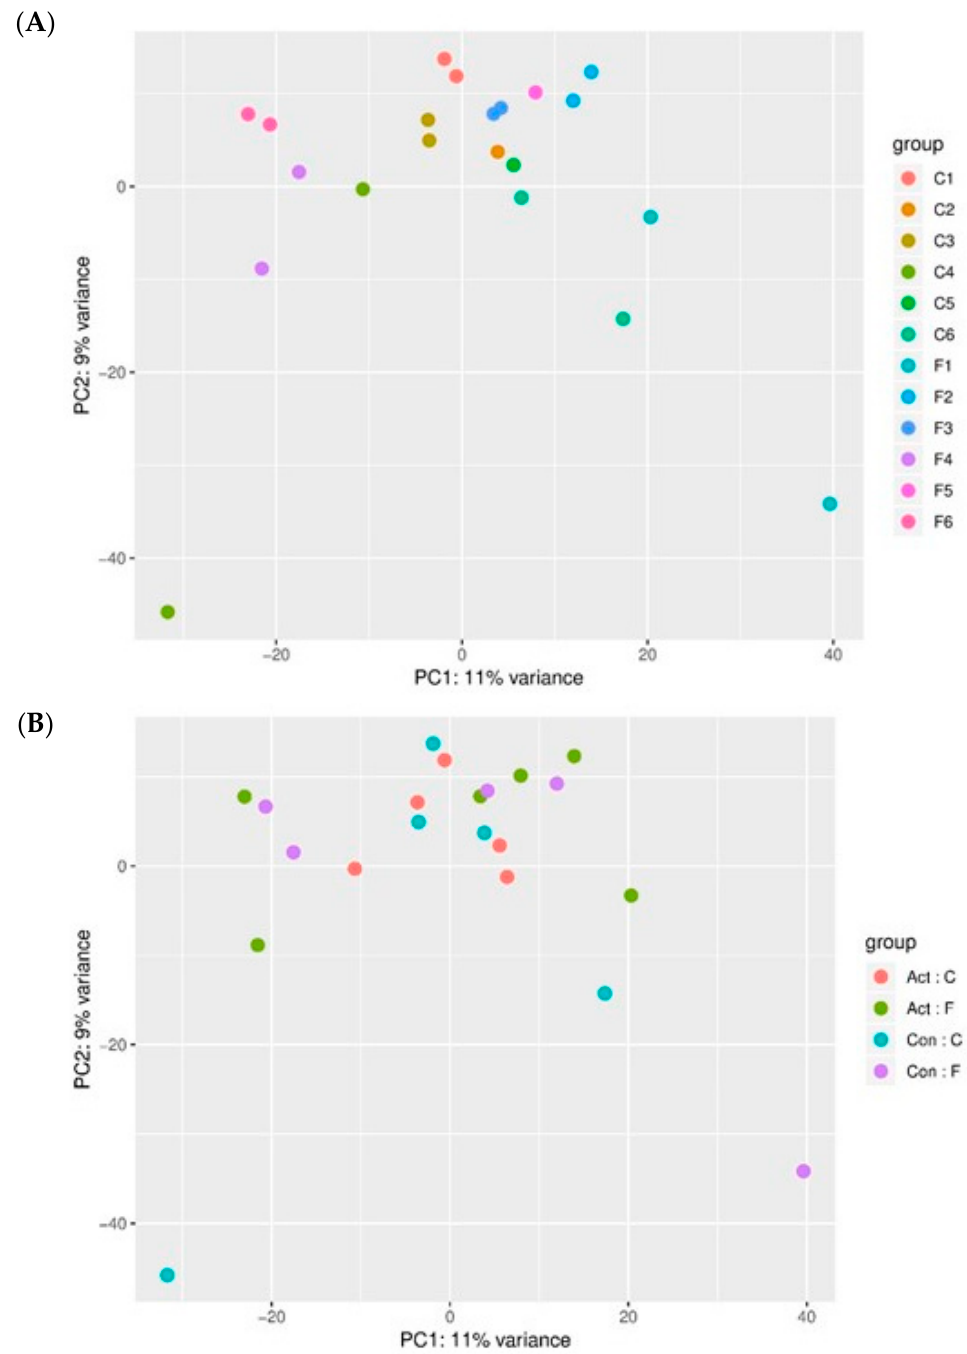
Figure 1. Donors group together. ( A ) PCA plot depicting inter-donor variability; ( B ) PCA plot depicting inter-experimental variability. Non-supervised principal component analysis shows that donors tend to group together, indicating that the variation between the control and FOP samples is larger than the comparison between control and experimental conditions. Inter-donor variability is shown in Figure 1A; each control and each FOP sample is represented by two same-colored dots, one indicating the control condition and one indicating the experimental condition (+Activin-A). Inter-experimental variability is shown in Figure 1B, each experimental condition is depicted by dots of the same color. Act:C = Control samples with Activin-A, ACT:F = FOP samples with Activin-A, Con: C = Control samples without Activin-A, Con:F = FOP samples without Activin-A. Samples Control 2 with Activin-A, Control 5 without Activin-A, and FOP 5 without Activin-A did not pass the QC filters and were not used in these and subsequent